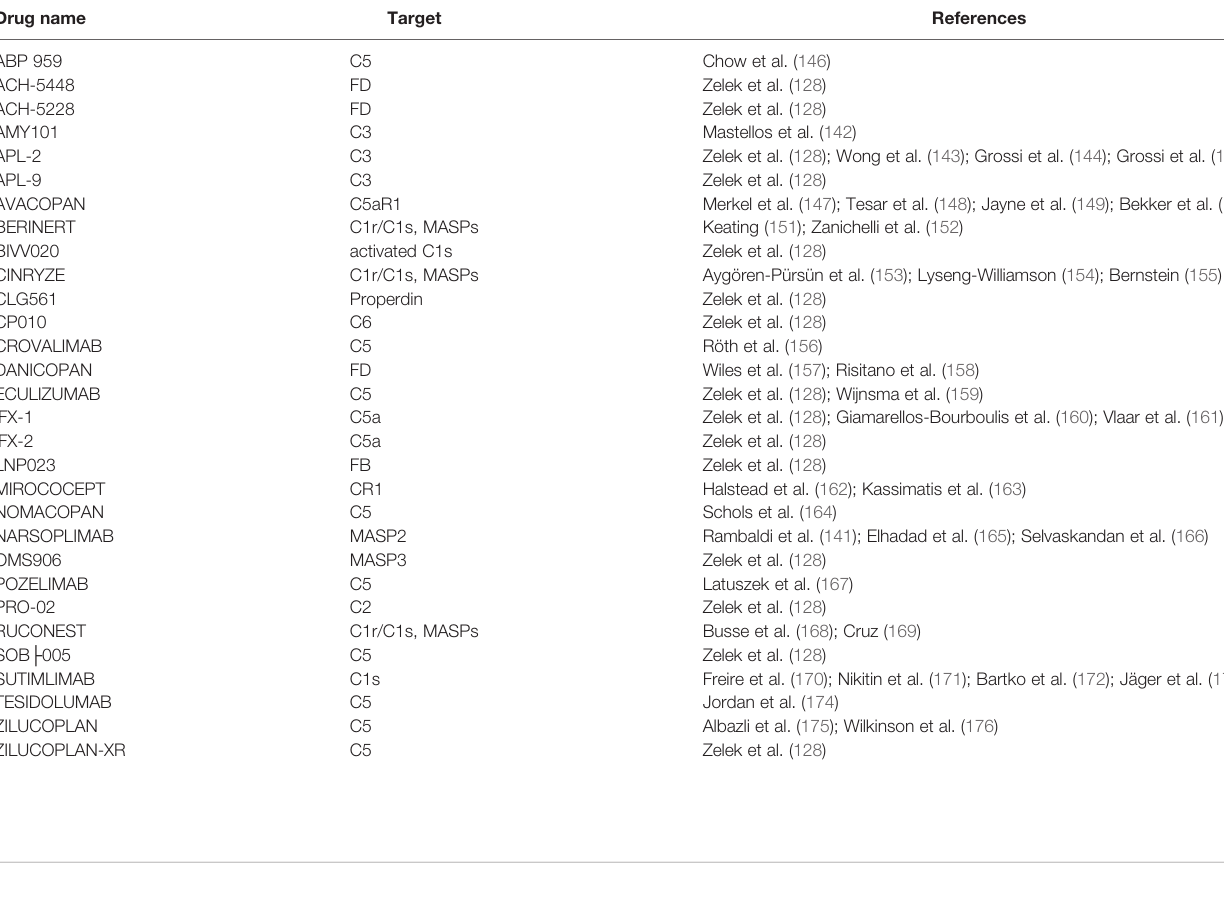
TABLE 1 | Principal anti-complement drugs.